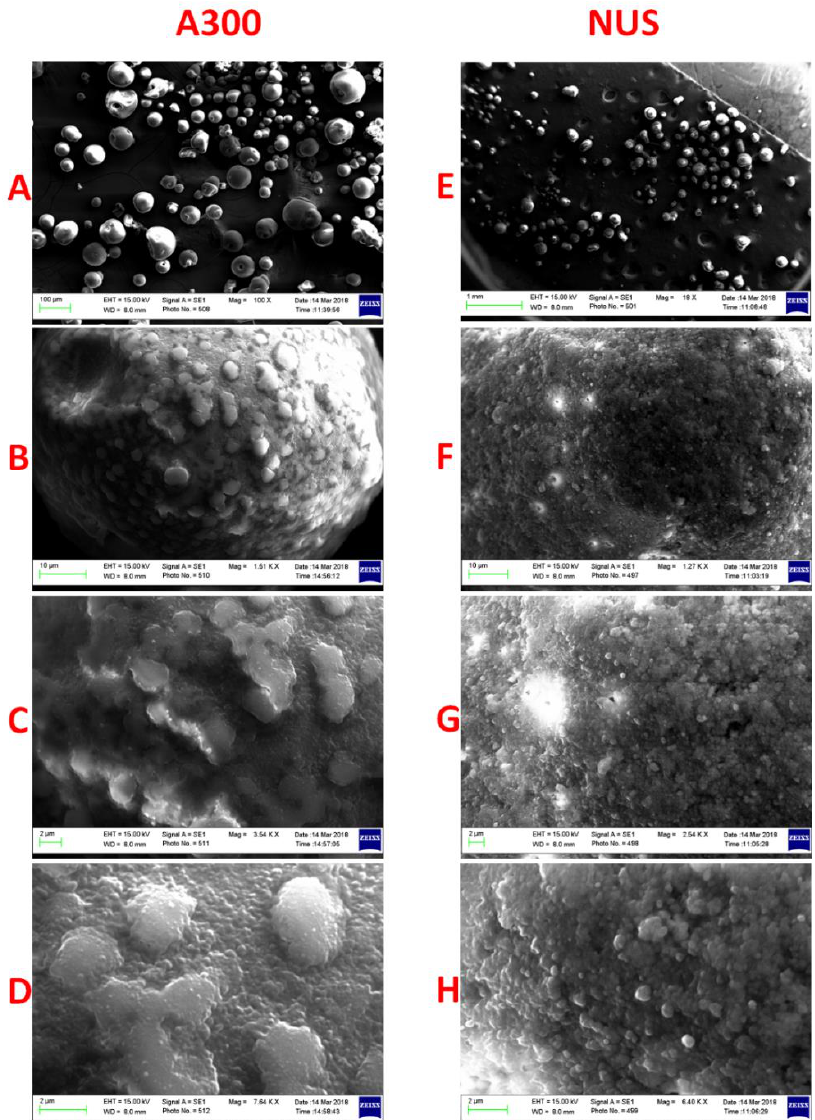
Figure 6. SEM images of ( A – D ) A300 representative solidified SNEDDS and ( E – H ) NUS representative solidified SNEDDS at ascending magnifications (100–7640× and 18–6400×, respectively).